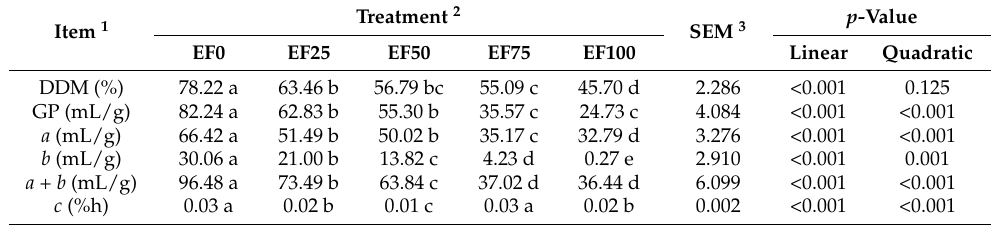
Table 2. The characteristics of gas production (GP) of different treatments for 48 h in vitro fermentation.